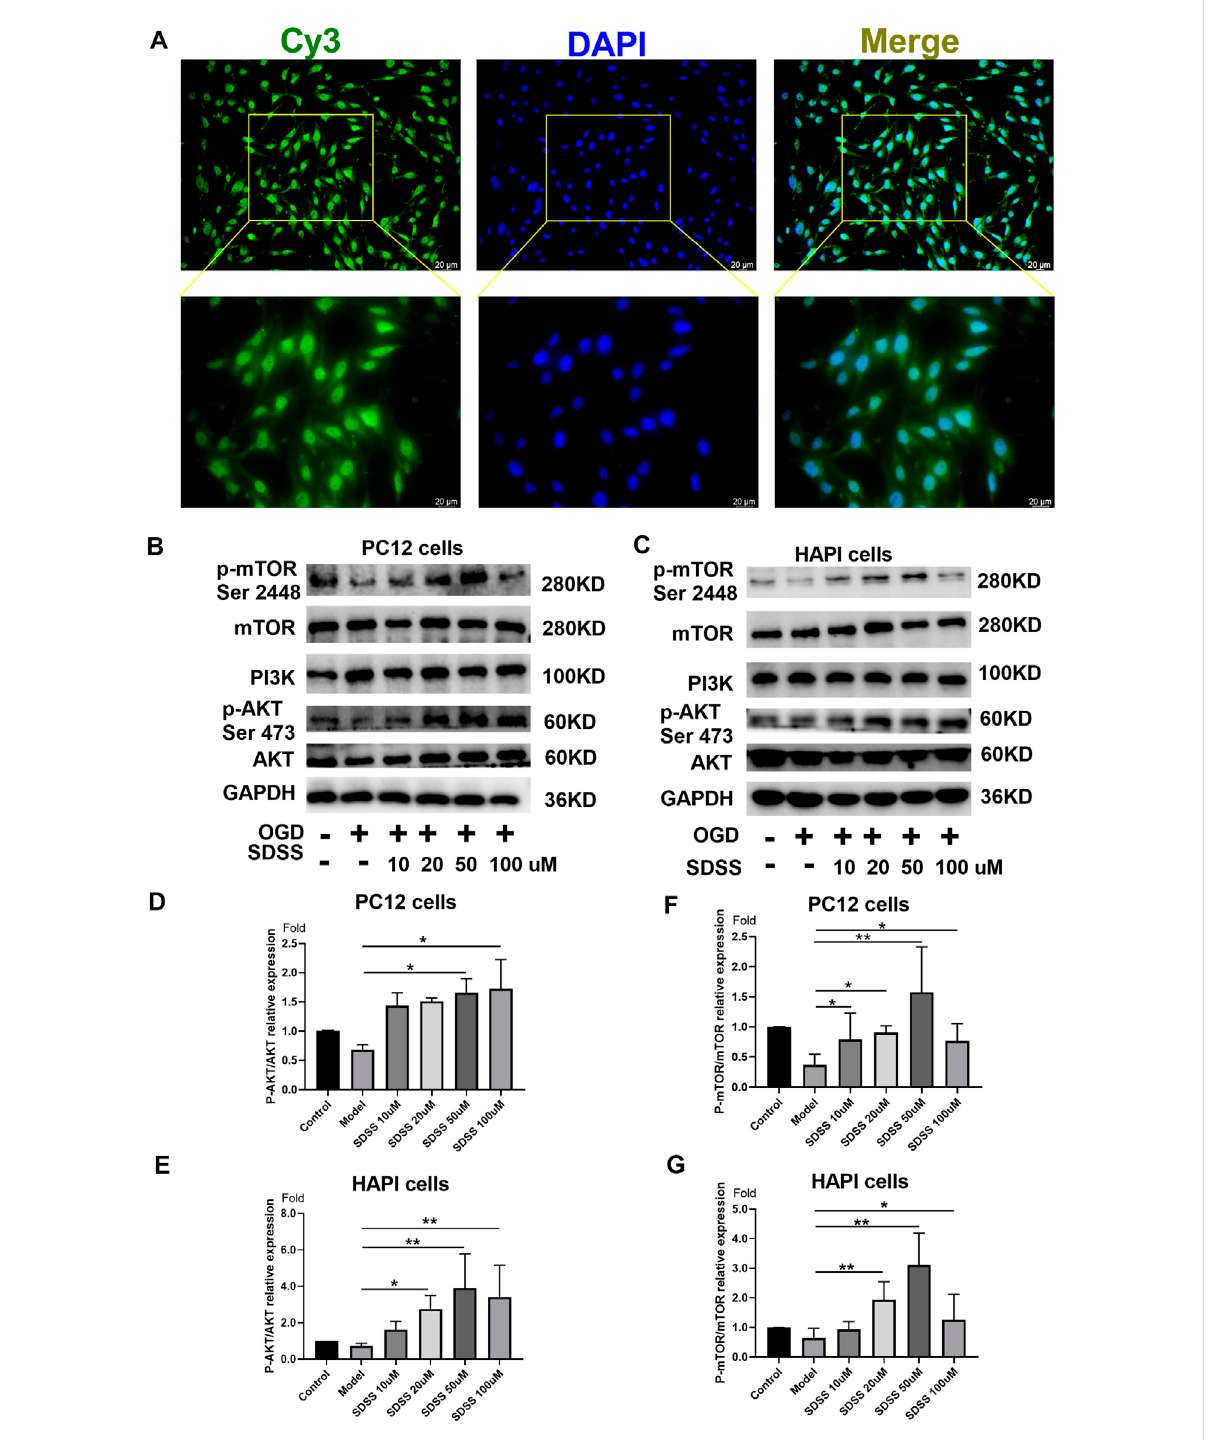
FIGURE 3 SDSS islocalized inthe cell and activates AKT1 phosphorylation. (A) Bio-SDSS distributionin HAPI cells. Expression levels ofp-mTOR (ser2448), PI3K, and P-AKT in PC12 cells (B) and HAPI cells (C) , as shown by Western blot. Quanti fi cation of the expression levels of p-mTOR (ser2448) (D) and p-AKT (E) inPC12cells.Quanti fi cationoftheexpressionlevelsofp-mTOR(ser2448) (F) andp-AKT (G) inHAPIcells.Numberofreplicates=3.*= p < 0.05; ** = p <